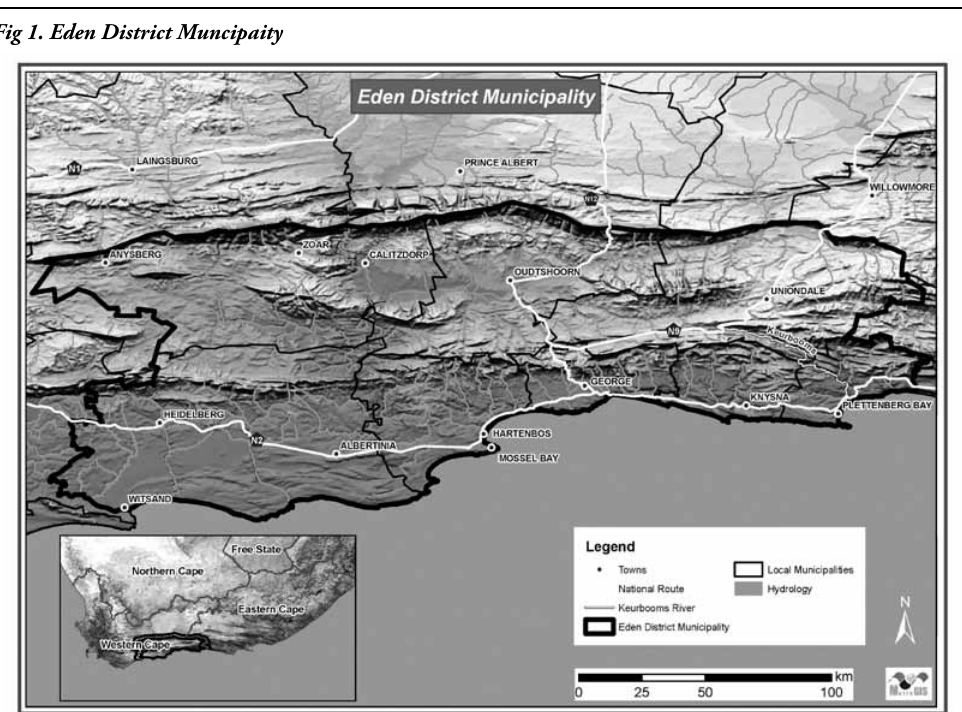
Fig 1. Eden District